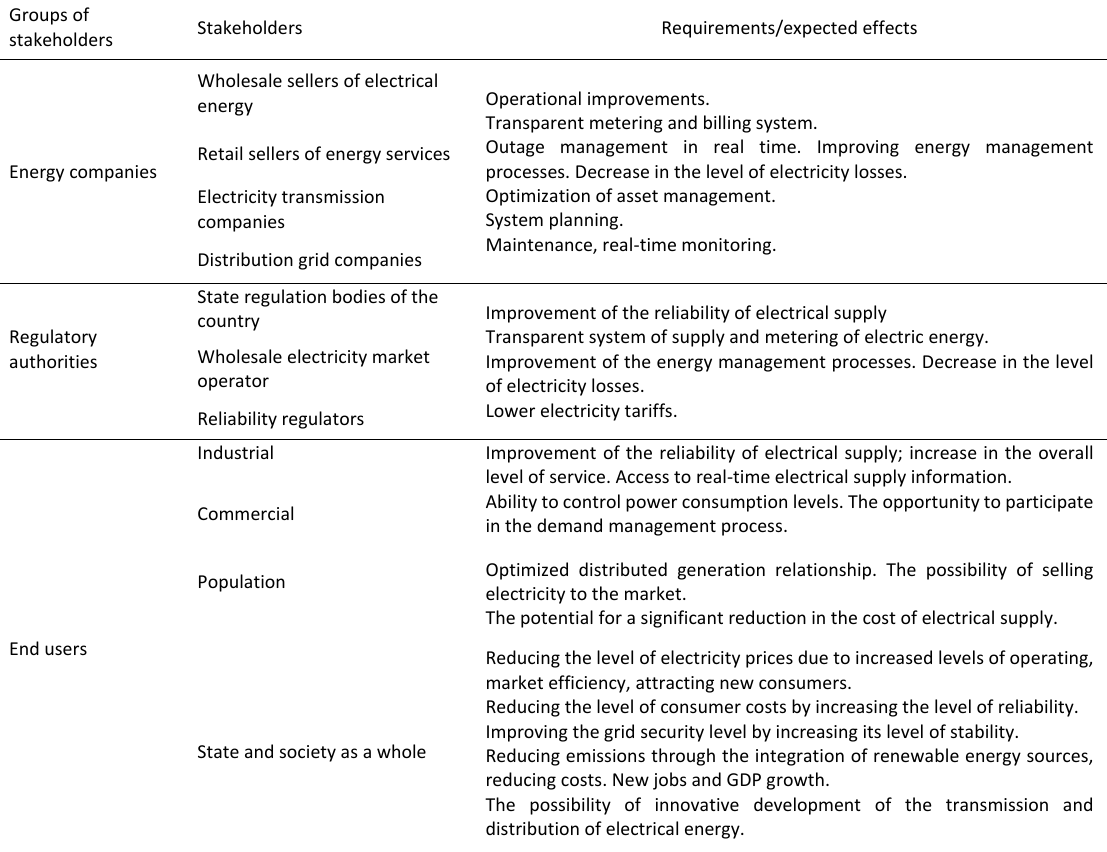
Table 5: Requirements of stakeholders for implementing the “Smart Grid” concept in the energy industry (systematized by the author) Groups of stakeholders Operational improvements. Transparent metering and billing system.